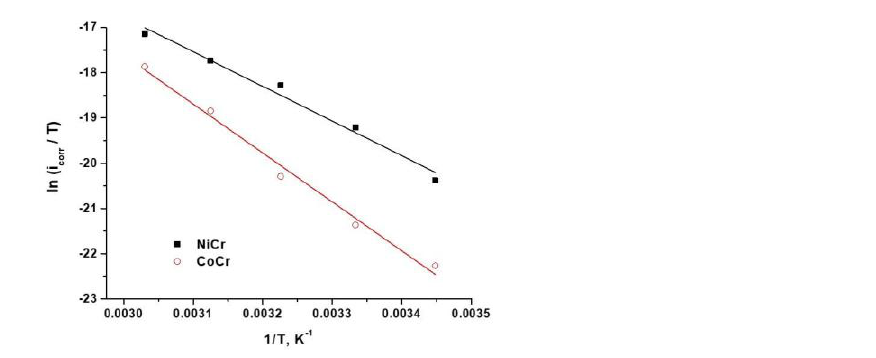
Figure 8. Plots of the transition state in artificial saliva for the two studied alloys in artificial saliva.